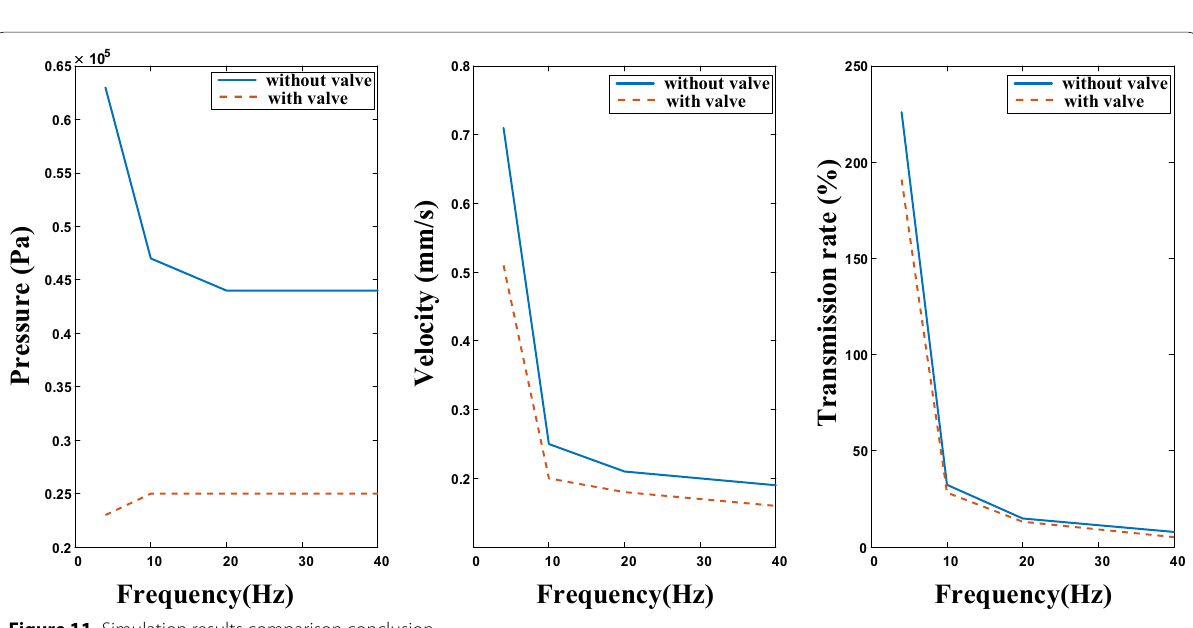
Figure 11 Simulation results comparison